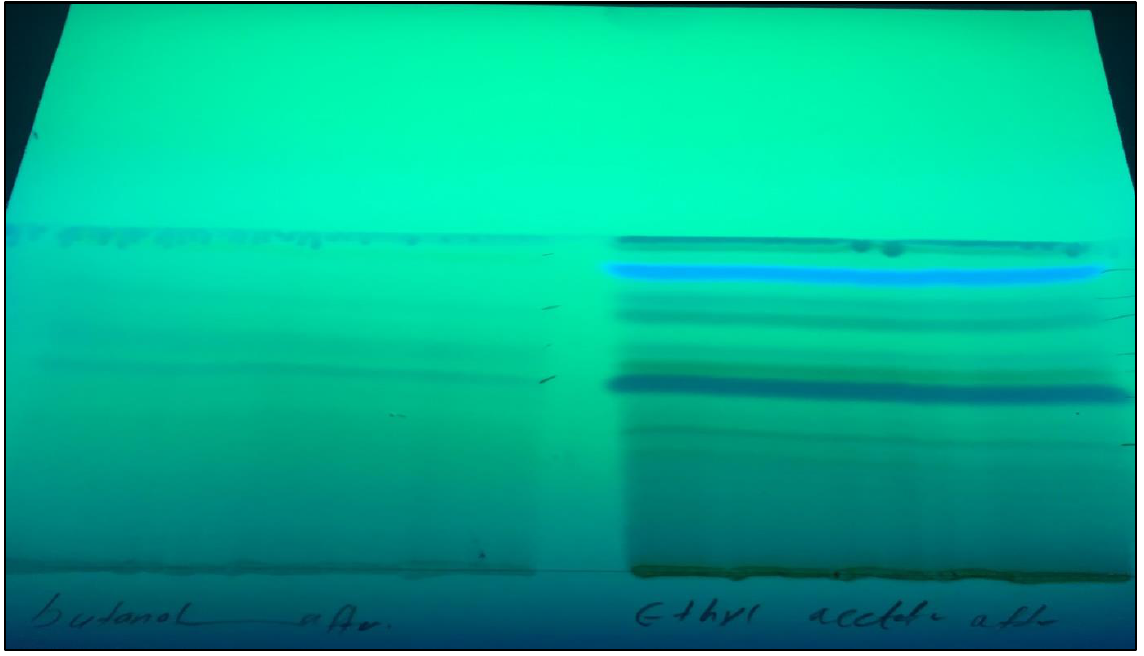
Figure 3. preparative Thin layer chromatography on silica gel GF 254 for fractions (1) Fraction of ethyl acetate after hydrolysis (2) fraction of n-butanol after hydrolysis. Using solvent system P1(CHCl 3 :CH 3 OCH 3 : HCOOH) in a ratio (75:16.5:8.5). The detection under UV light 365 and 254